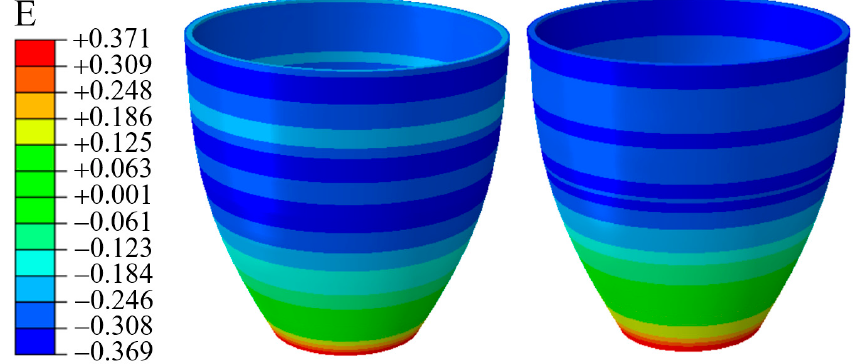
Figure 22. Strain distribution in cases of 11.9 MPa and 13.9 MPa.